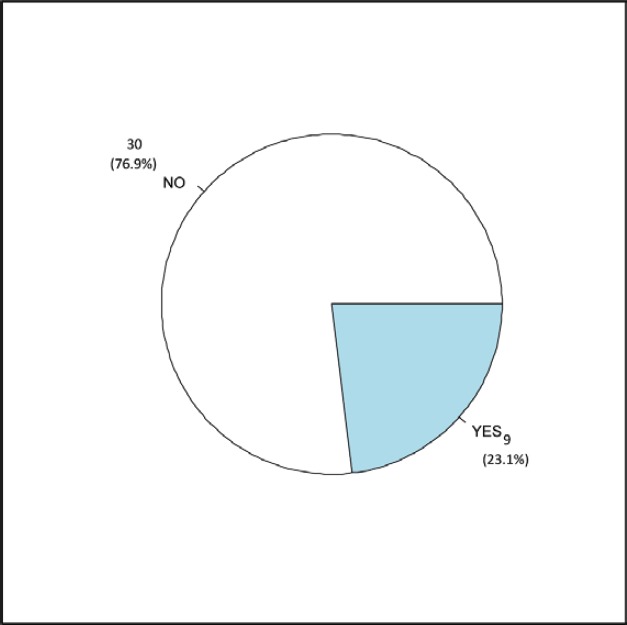
Complications rate.